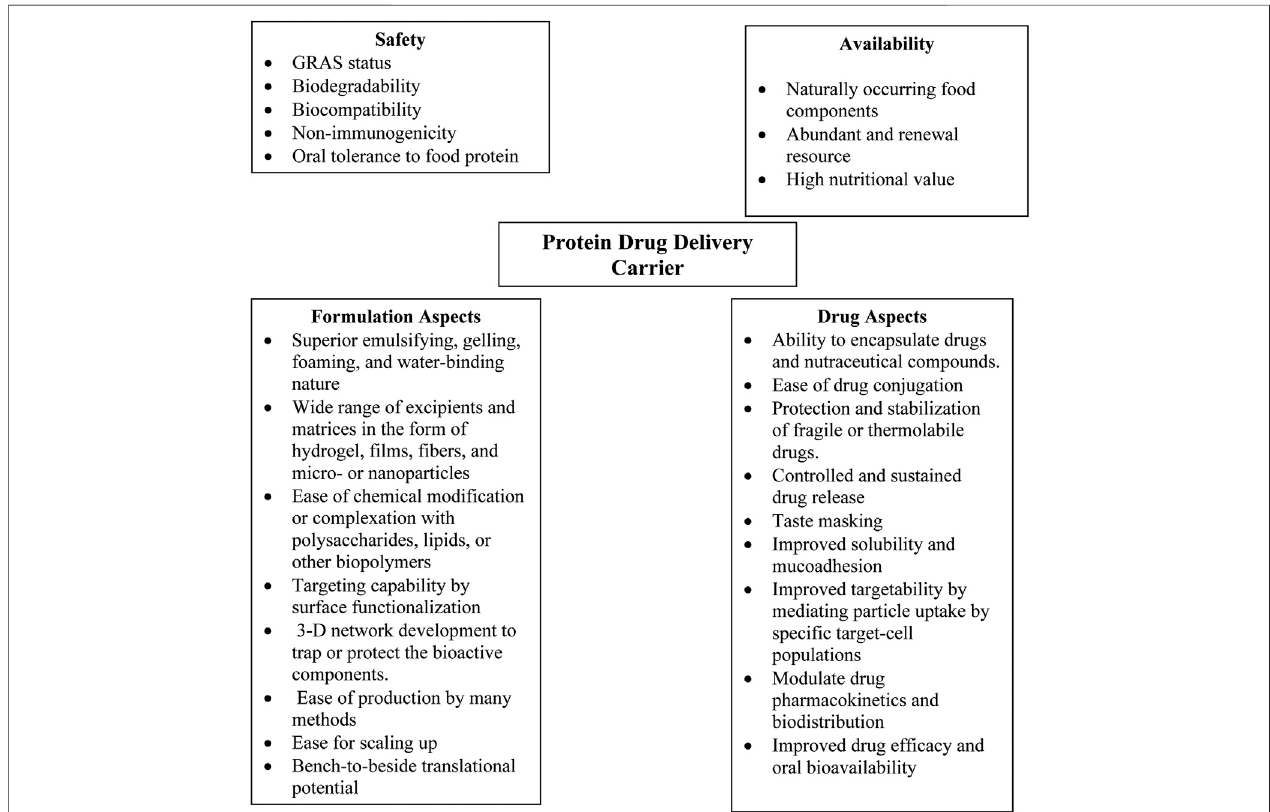
FIGURE 3 | Advantages of proteins as drug delivery